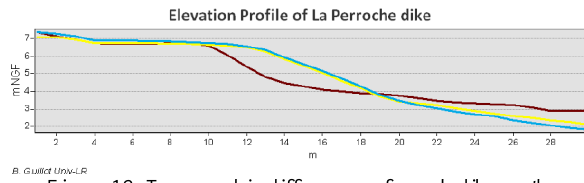
Figure 12: Topographic differences of a rock dike on the Perroche Bay (Oleron